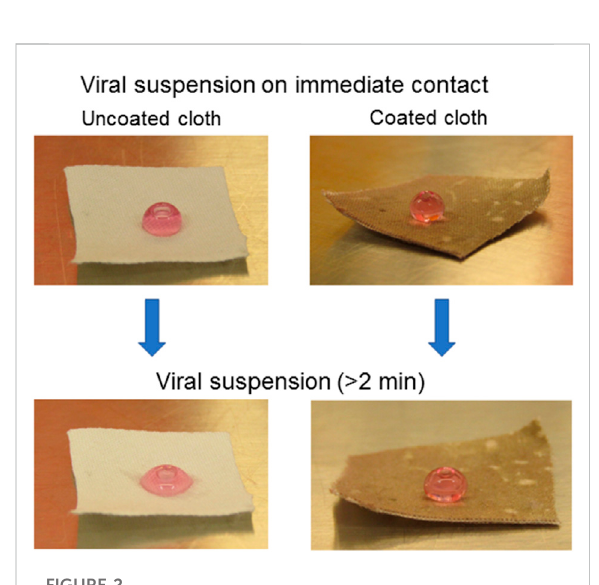
and after some time ( > 2 min) on uncoated and coated cloth.